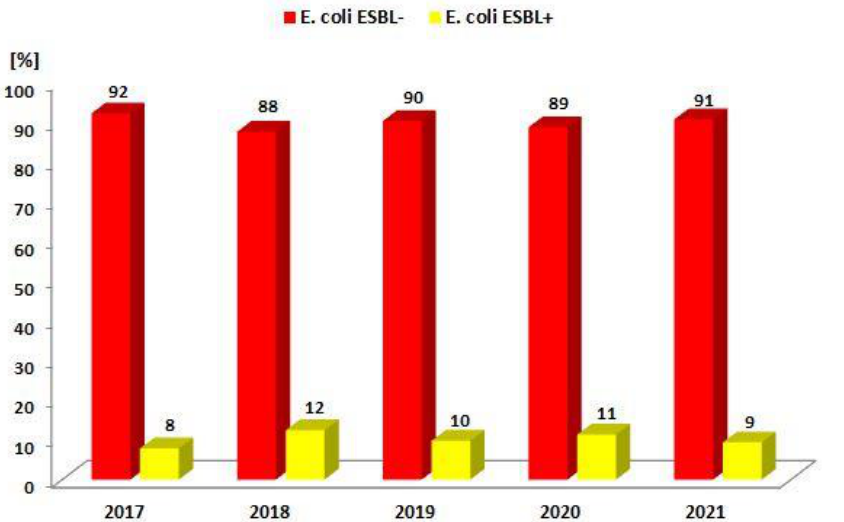
Figure 2. Comparison of the percentage of E. coli ESBL(+) and ESBL( − ) strains from 2017 to 2021.